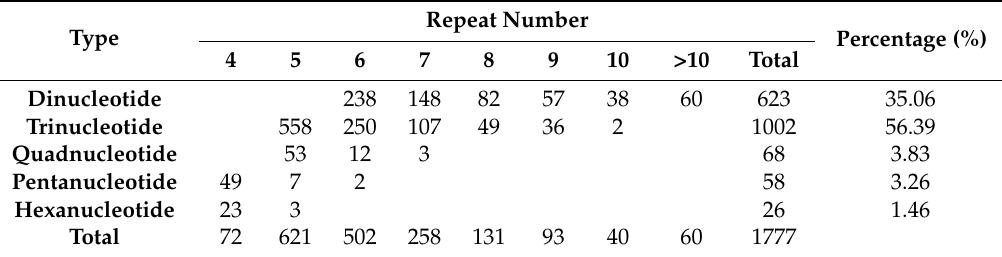
Table 3. Distribution of EST-SSR